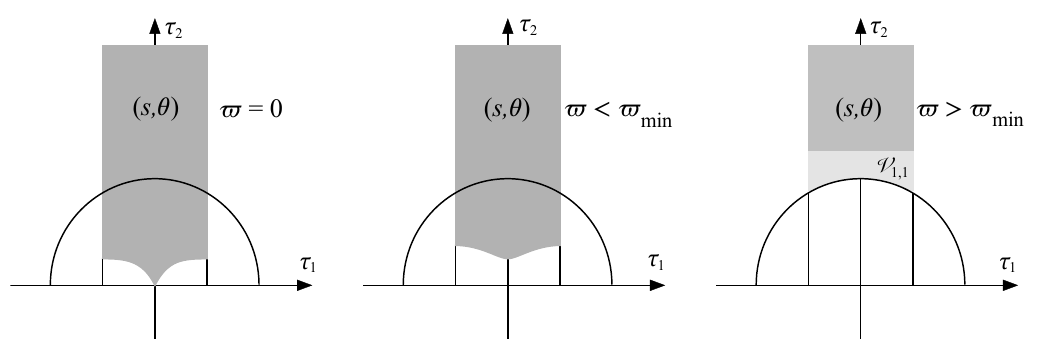
Figure 4 . Region of the moduli space of the 1-punctured torus covered by the propagator diagram. When the stub length is too small, in the range 0 < $ < $ min , the covered area exceeds the fundamental region, which implies that some surfaces are counted more than once. We assume that $ > $ min , which leaves part of the moduli space uncovered, but does not overcount surfaces. The missing region of the moduli space de(cid:12)nes V 1 ; 1 . Note that the propagator region is bounded from below by a curve corresponding to setting the Schwinger parameter s to zero. This curve attains its minimum imaginary part on the imaginary axis in the (cid:28) plane. However, for $ > $ min the imaginary part of the curve is very nearly constant, as implied by